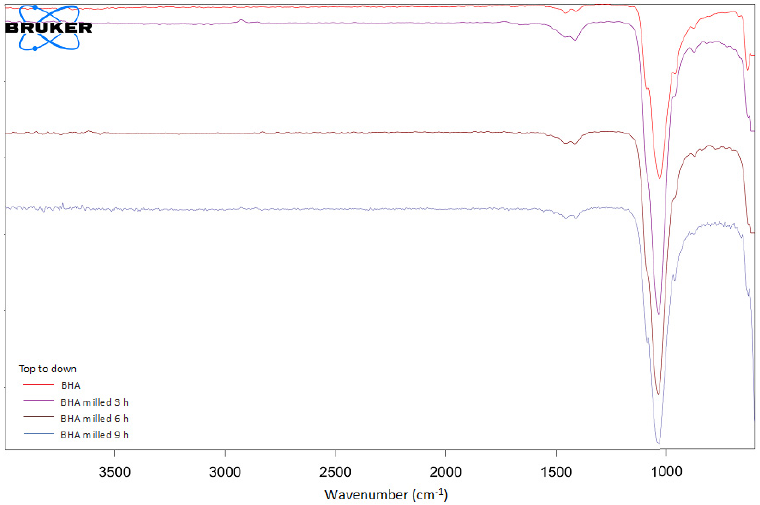
Figure 3. FTIR spectra of unmilled and milled BHA.